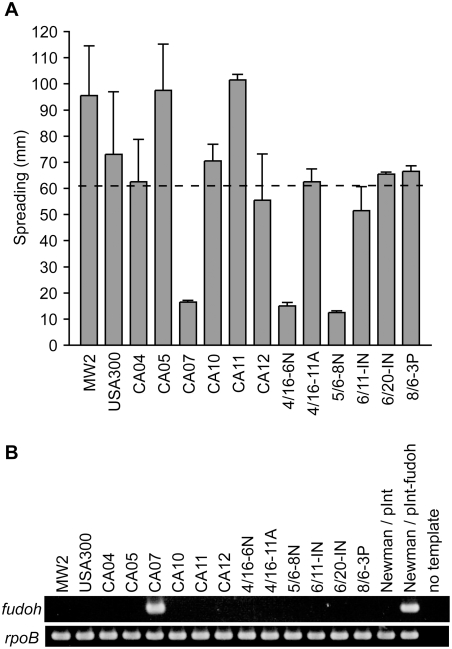
Colony spreading of CA-MRSA.(A) Overnight cultures of CA-MRSA strains were spotted onto soft agar plates and incubated for 10 h at 37°C. The dotted line indicates the averaged value. (B) The DNA fragments containing fudoh and the partial region of rpoB were amplified by PCR using the CA-MRSA genomes, Newman/pInt genome, or Newman/pInt-fudoh genome as the template. The amplified DNA was electrophoresed in 1% agarose gel and stained with ethidium bromide.